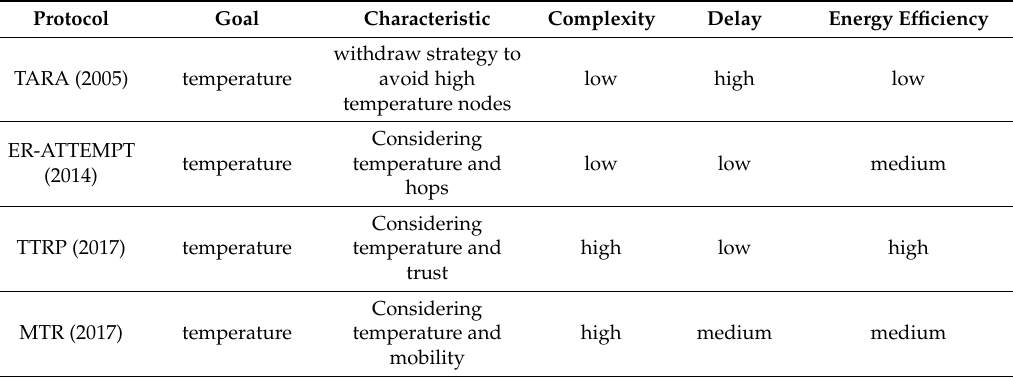
Table 3. Comparison of temperature-based routing